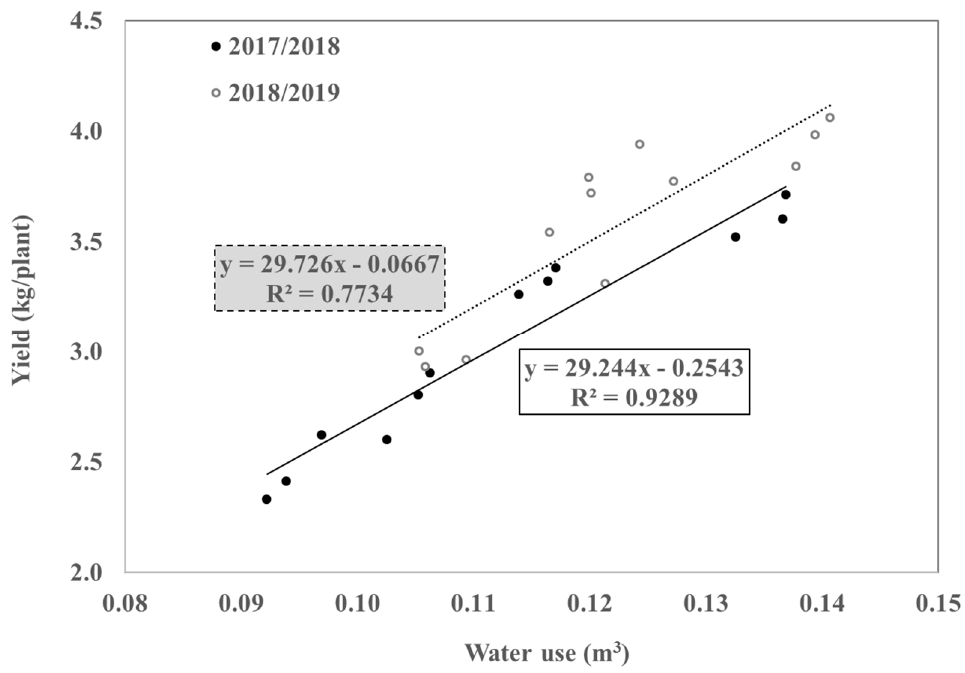
Figure 5. The correlation between applied water and yields in 2017–2018 and 2018–2019.